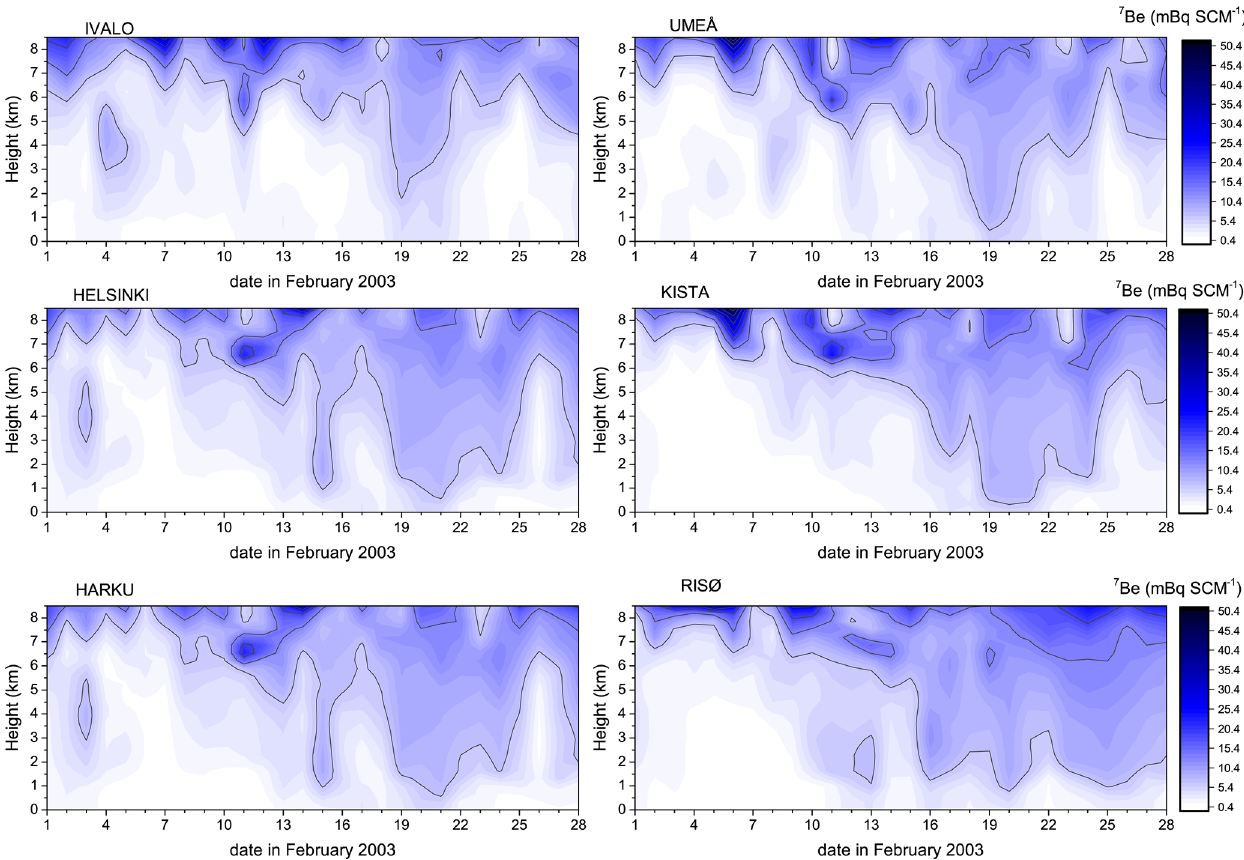
Figure 11. Time–height cross sections of simulated hourly 7 Be concentrations (mBqSCM − 1 where SCM stands for standard cubic meter) during the month of February 2003 at the six sampling